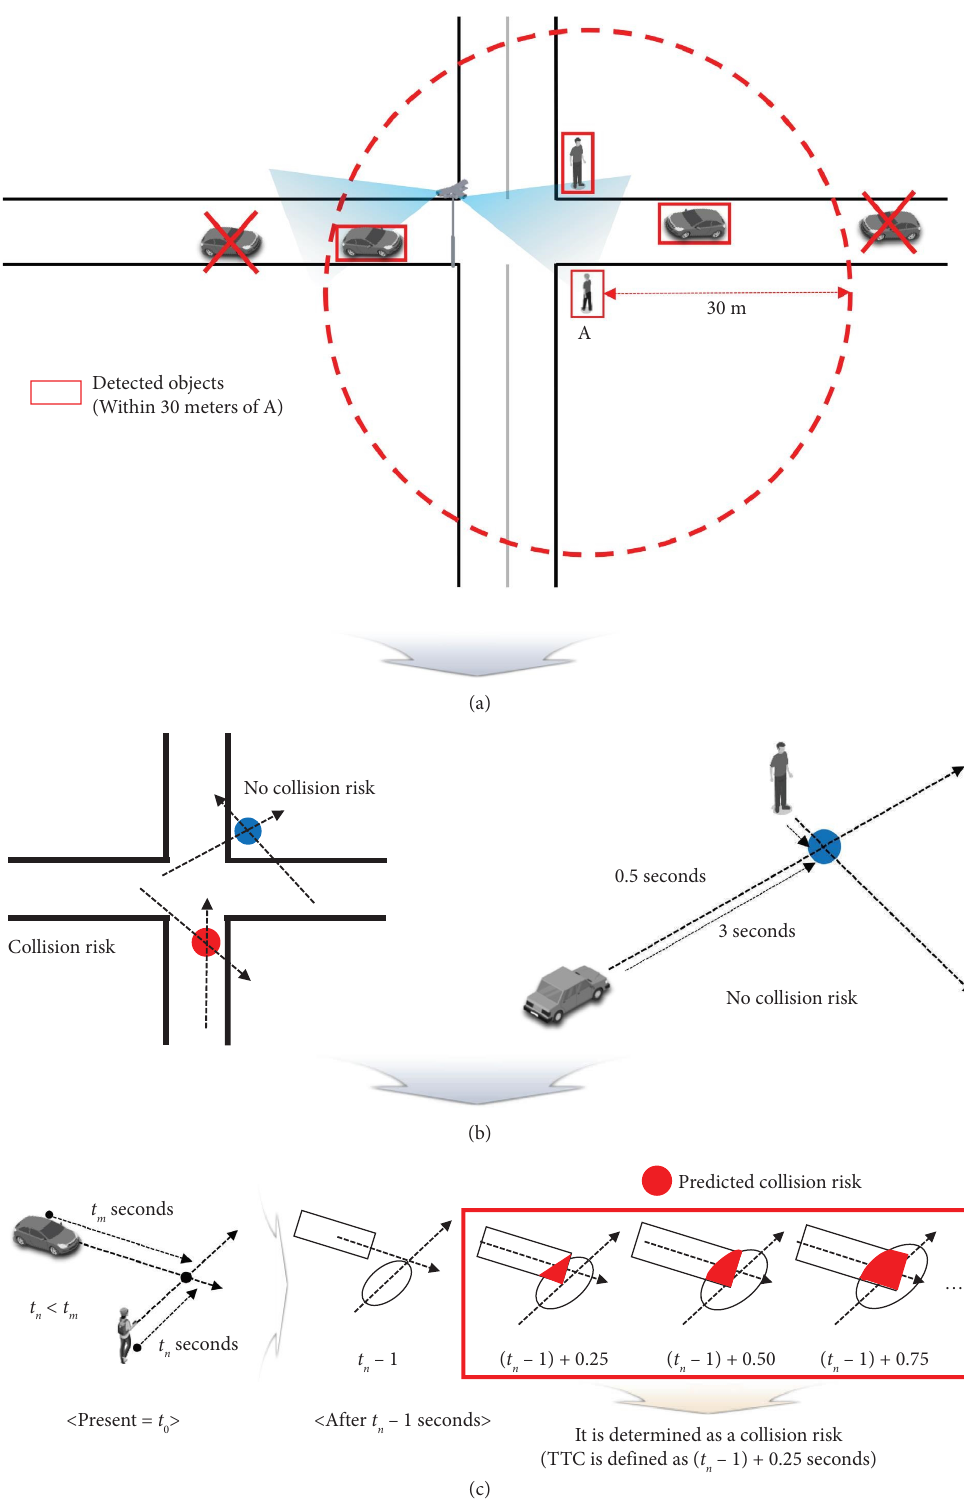
Figure 6: Tree-step method to identify risky situations. (a) Two objects are excluded as the distances from object A exceed thirty meters. (b) Intersecting points (blue dots) are excluded since the point is outside local roads or the time diference in arrival times to the point exceeds two seconds. (c) If reachable areas overlap three times consecutively, the situation is considered to be a collision risk, and TTC is defned as the time when the two reachable areas frst